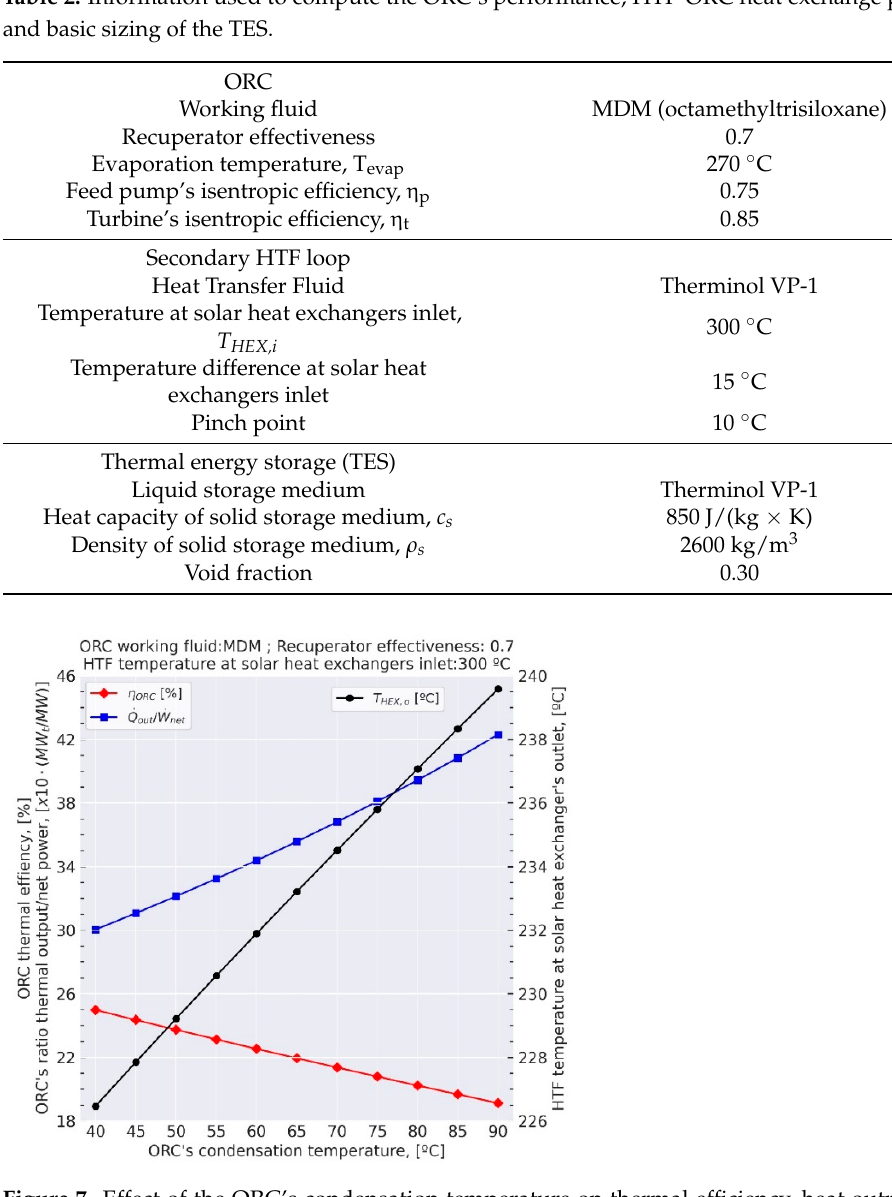
Table 2. Information used to compute the ORC’s performance, HTF-ORC heat exchange processes, and basic sizing of the TES.